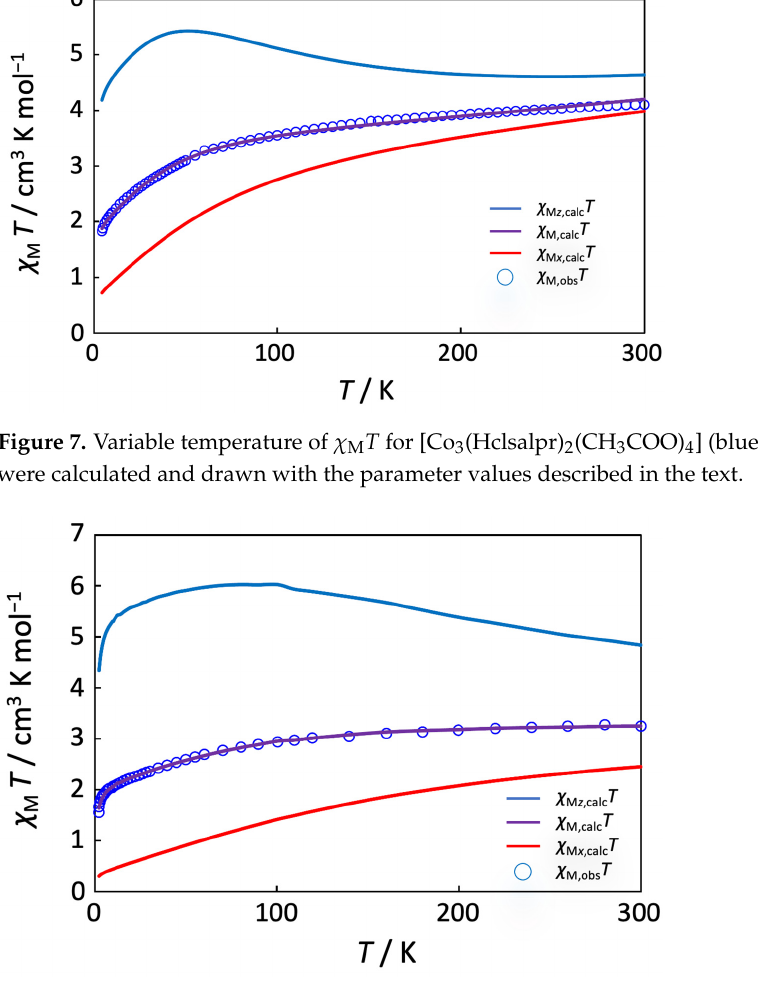
Figure 8. Variable temperature of χ M T for [Co 3 (Hsalpr) 2 (CH 3 COO) 4 ] (blue circle) from the data in [40]. The solid lines were calculated and drawn with the parameter values described in the text.